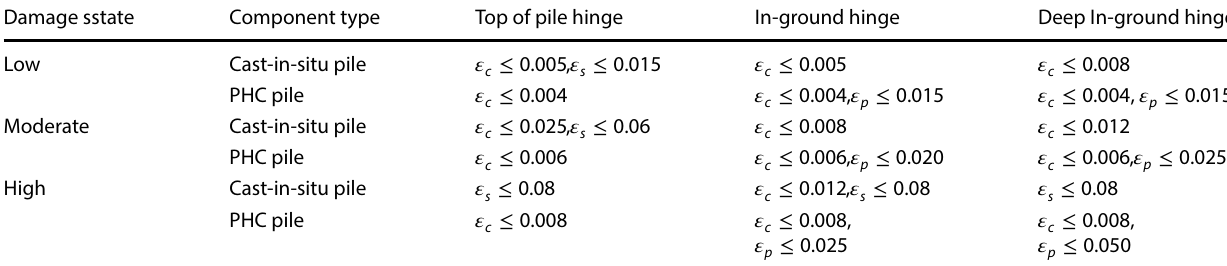
Table 1 Damage states for wharves Damage